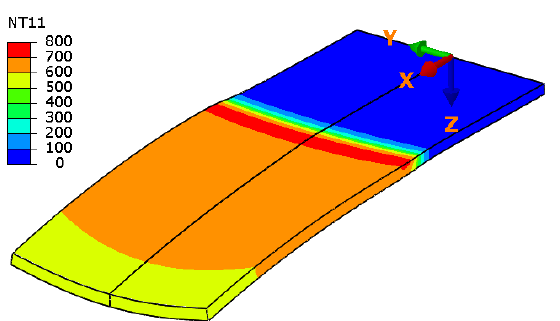
Figure 8. Temperature distribution during laser heating (t = 39 s, region 0 ≤ x ≤ 50, deformation scale factor 10).